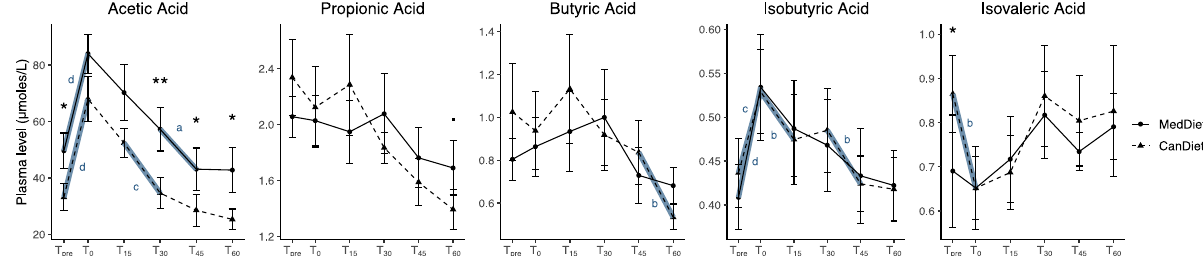
Figure 3. Response curves of SCFA to maximal aerobic test according to the diet. The graph represents the means with the standard errors of the plasmatic SCFA concentrations at each time point for the two diets. T pre corresponds to the initial concentration before the aerobic test, T 0 corresponds to the immediate end of the aerobic test and T 15 , T 30 , T 45 and T 60 correspond to the recovery phase. SCFA concentrations have been normalized using ranked values fitted into mixed linear-effect models (LME) and differences between diets and times have been tested by analysis of variance (ANOVA). For difference between diets, significance was set at p < 0.1 (.), p < 0.05 (*), p < 0.01 (**) and p < 0.001 (***). For difference between times, indicated by bold blue line, significance was set at p < 0.1 (a), p < 0.05 (b), p < 0.01 (c), p < 0.001 (d). N = 7 per